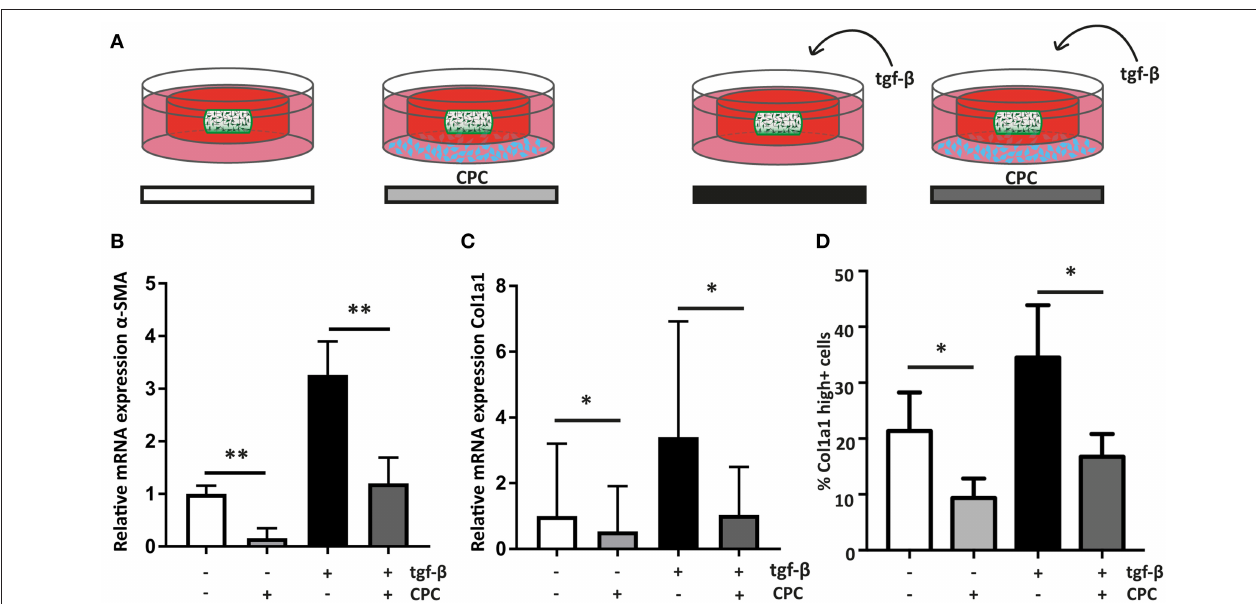
FIGURE 4 | Cardiac progenitor cells attenuate the cardiac fibroblast mediated fibrotic response. (A) Schematic overview of the experimental set-up. (B) CPC attenuate α -SMA expression in hfCF-laden GelMA in culture conditions with or without 2ng/ml TGF- β 1 stimulation ( n = 13). (C) Col1a1 expression is lower in co-culture conditions ( n = 12) and (D) likewise, the amount of highly Col1a1 positive cells is 2-fold lower in CPC-treated gels ( n = 4). Statistical significance was assessed using repeated measures two-way ANOVA. ** p < 0.01 * p < 0.05.